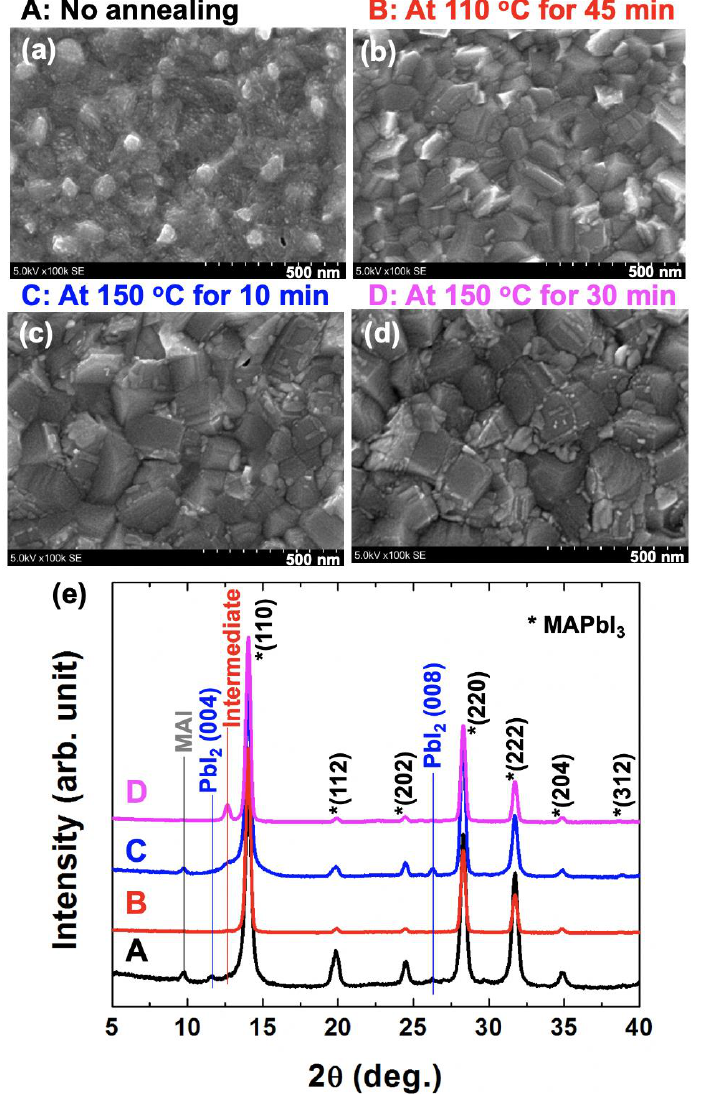
Figure 2. ( a – d ) The surface morphologies by SEM measurements and ( e ) XRD results with variable post-annealing conditions, A: No annealing, B: At 110 °C for 45 min, C: At 150 °C for 10 min, and D: At 150 °C for 30 min. In the typical annealing condition (B: for solar cell application) for MAPbI 3 (*), MAI, PbI 2 , and intermediate phases were not observed.